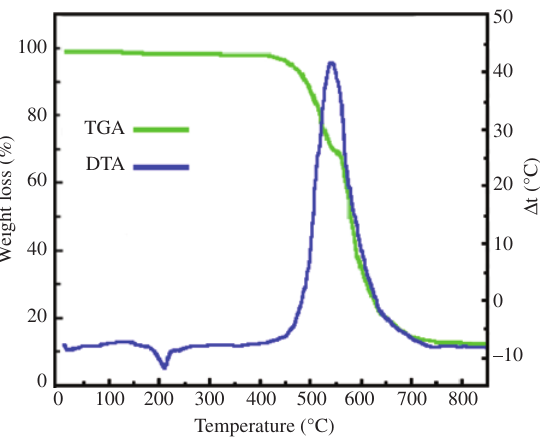
Figure 3: TGA and DTA diagrams of complex 1 .